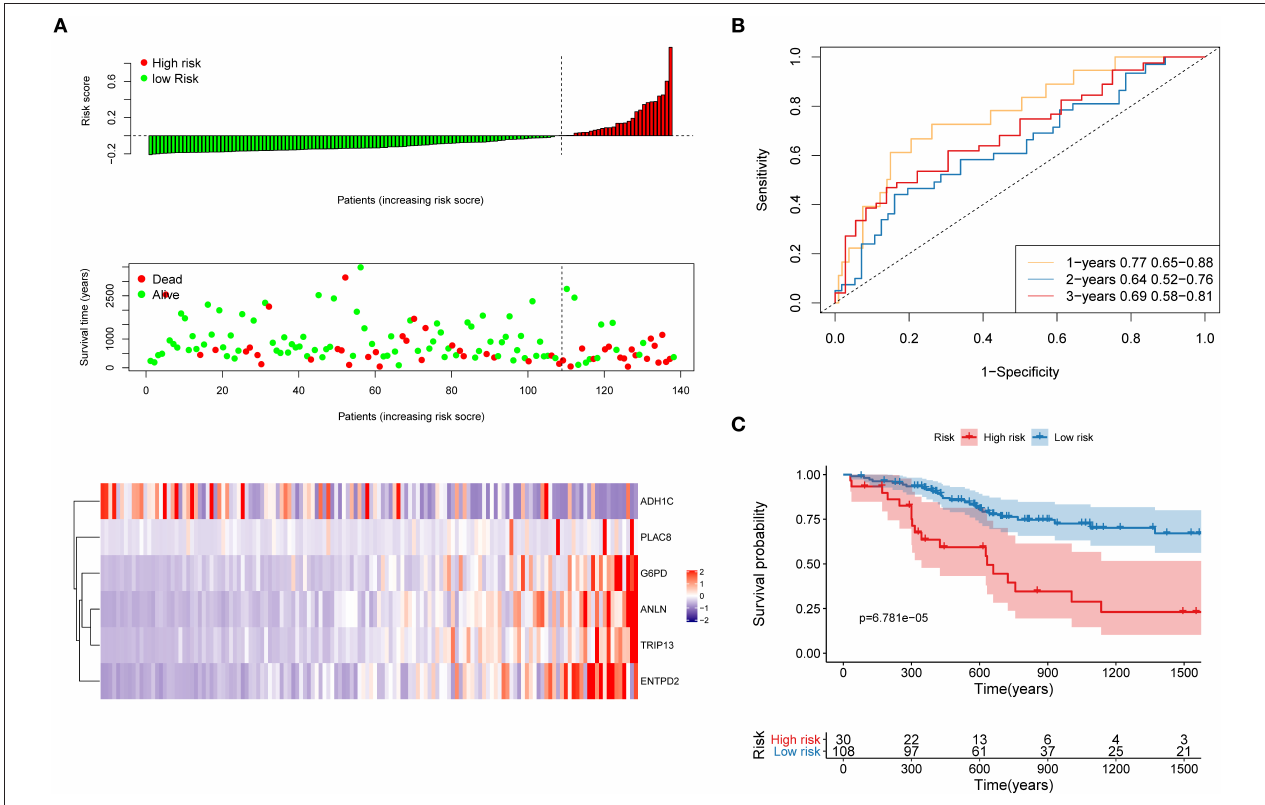
FIGURE 8 | Internal validation of the risk model. (A) Distribution of risk score, OS, survival status (red dots indicate death, blue dots indicate alive) and the six genes expression heat map in the internal validation cohort; (B) ROC curves and AUC for 1-, 2-, and 3-year survival in the internal validation cohort of the risk model; (C) KM curves of the OS in the internal validation